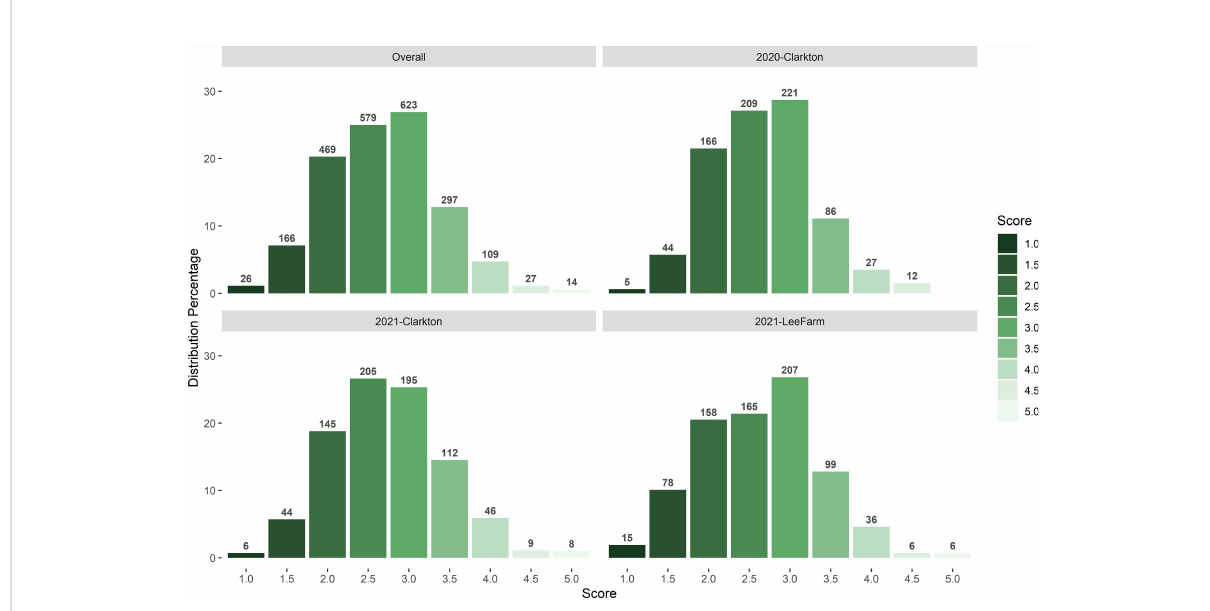
FIGURE 1 Distribution of off-target dicamba damage scores at each testing environment and across